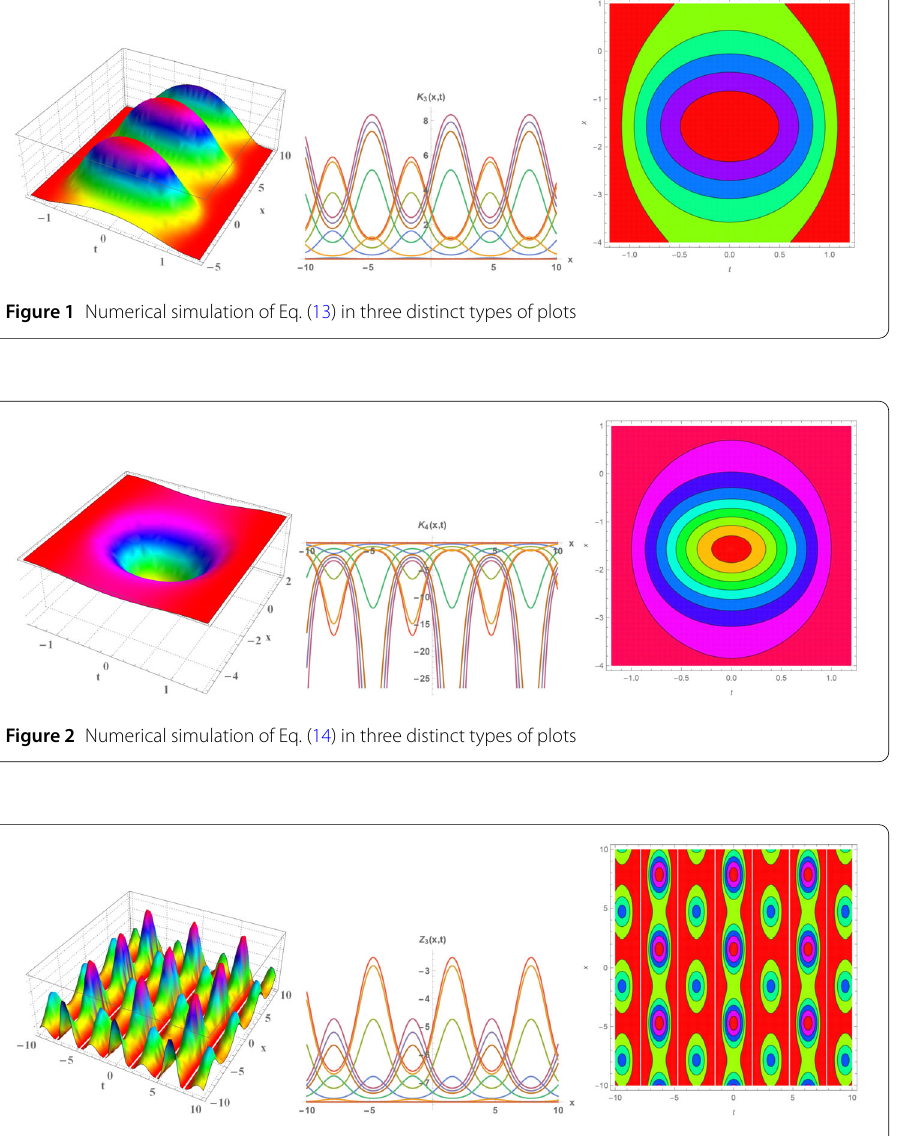
Figure 3 Numerical simulation of Eq. (40) in three distinct types of plots